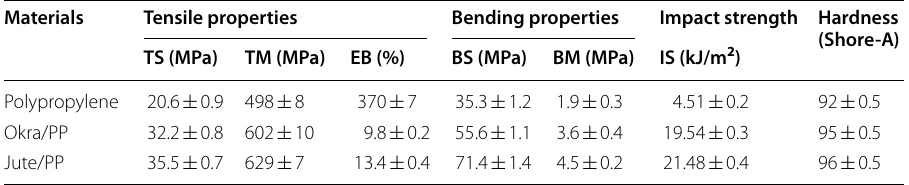
Table 1 Comparative tensile, bending, impact and hardness property of unreinforced PP sheet and